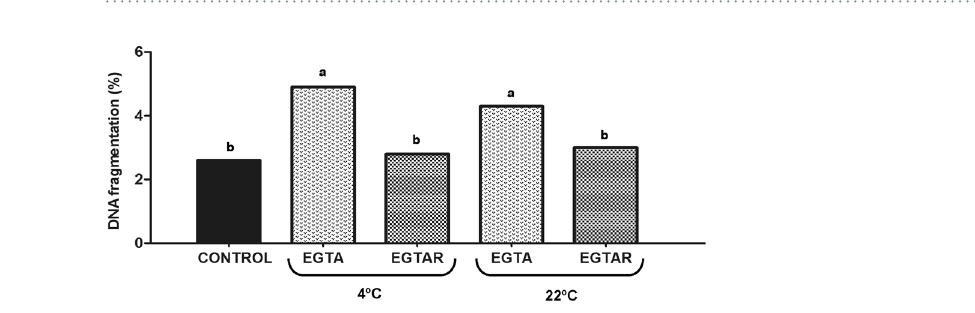
Figure 1. SCD-processed freeze-dried sperm sample with Syber-Green fluorescence: sperm nuclei with fragmented DNA exhibit a large and spotty halo of chromatin dispersion (arrow). Sperm nuclei that exhibited small and compact halos of chromatin dispersion corresponded to spermatozoa with unfragmented DNA.